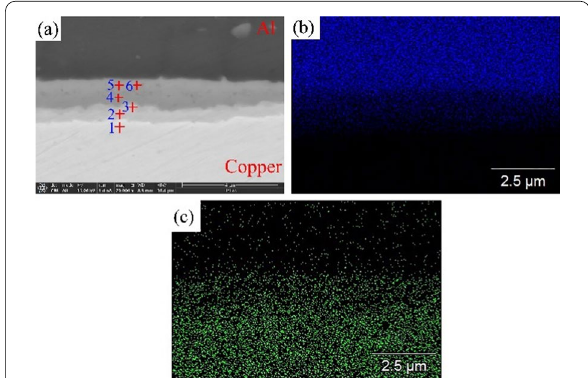
Figure 4 ( a ) SEM image of region I in Figure 3, and element maps for ( b ) Al and ( c ) Cu